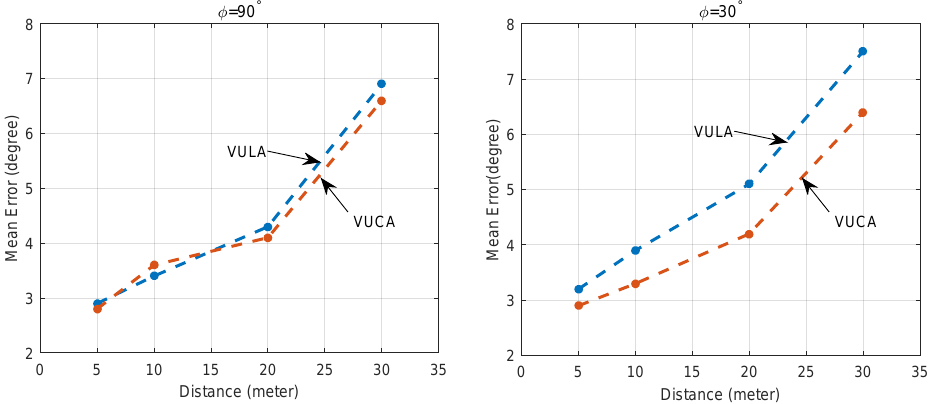
Figure 9. Mean error of direction finding when φ = 90 ◦ or 30 ◦ with different distances L